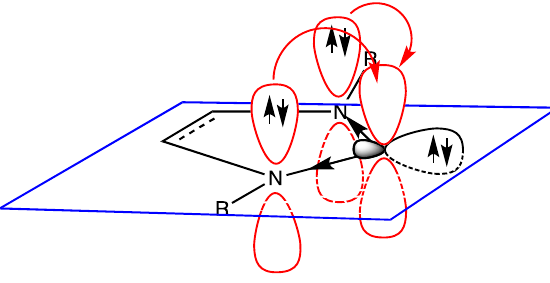
Figure 3. N -Heterocyclic carbenes: stabilization via δ -withdrawing and π -donating effects. Arrows: electrons.